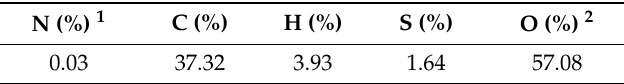
Table 2. Elemental analysis of softwood black